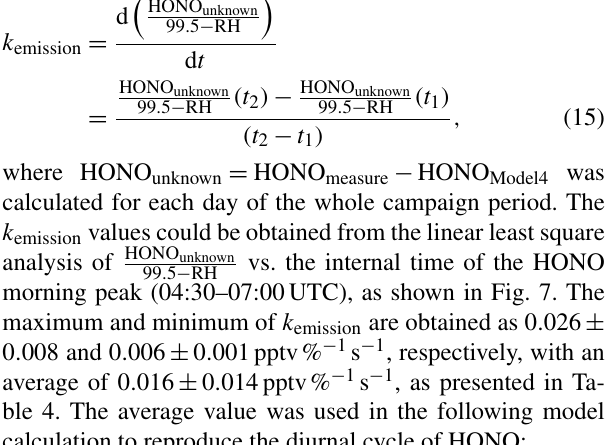
Figure 7. Example of HONO unknown as a function of time (zero point 99 . 5 − RH from time 04:30UTC) to estimate the temporary HONO emission rate from dew water ( k emission ). The blue line is the linear least square analysis of HONO unknown vs. the internal time to obtain the 99 . 5 − RH minimum (e.g., 22 April for the low slope) and maximum (e.g., 24 April for the high slope) of k emission